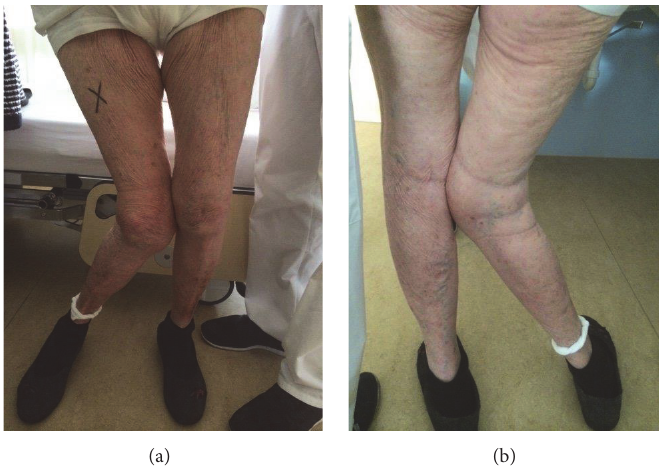
Figure 1: Preoperative anterior (a) and posterior (b) view images of the patient standing. A massive valgus knee deformity can be inspected.